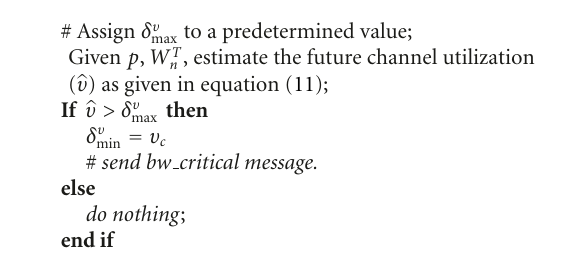
Algorithm 3: IAC/O: Adaptive estimation of δ υ min